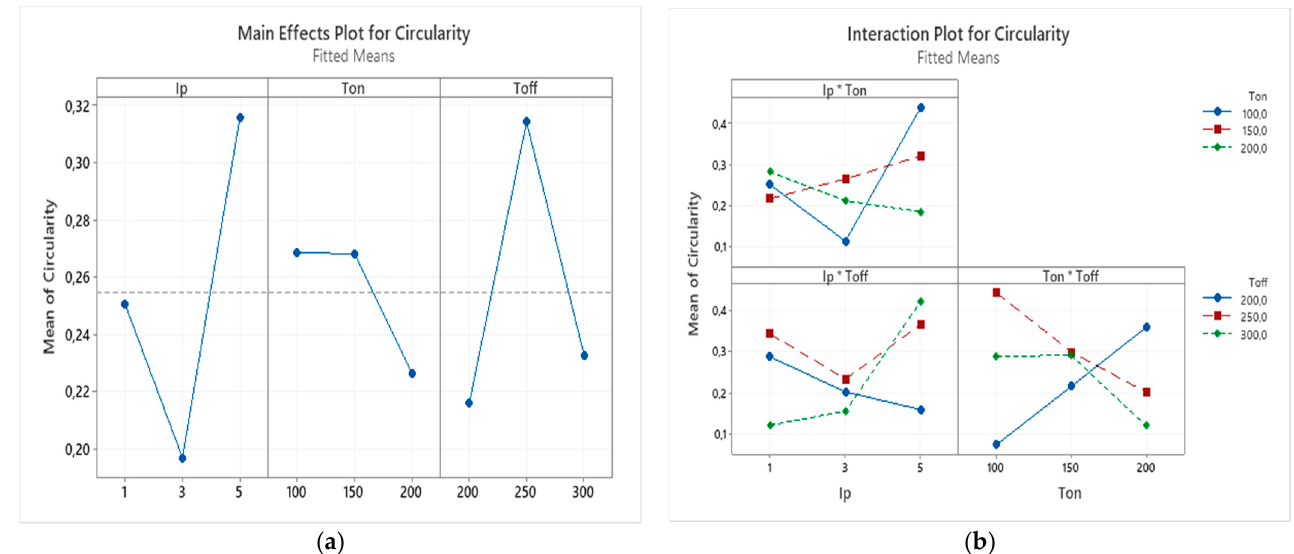
Figure 12. ( a ) The main effects and ( b ) the interaction effects plot for the circularity error.